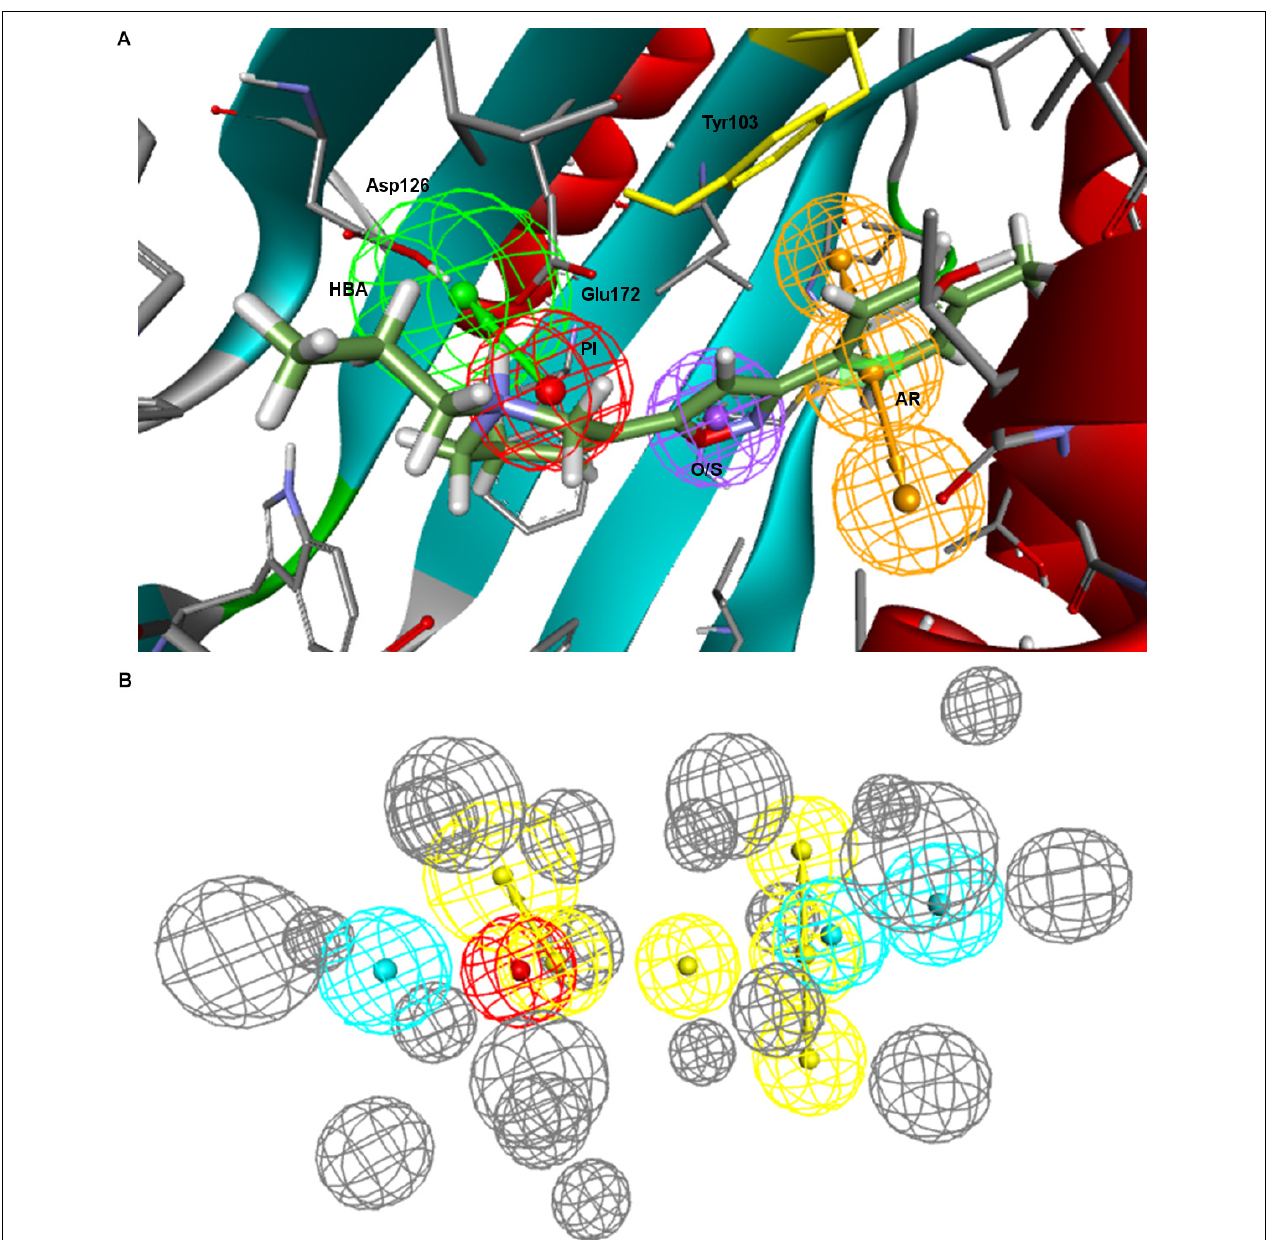
FIGURE 4 | (A) Gund–Ph positioned in the active site of the s1R by rigid ligand alignment. The AR features capture the pi-stacking with Tyr103, but there is no aromatic side chain on the other side for the interaction on the opposite direction; (B) Gund–Ph (yellow) overlapped with